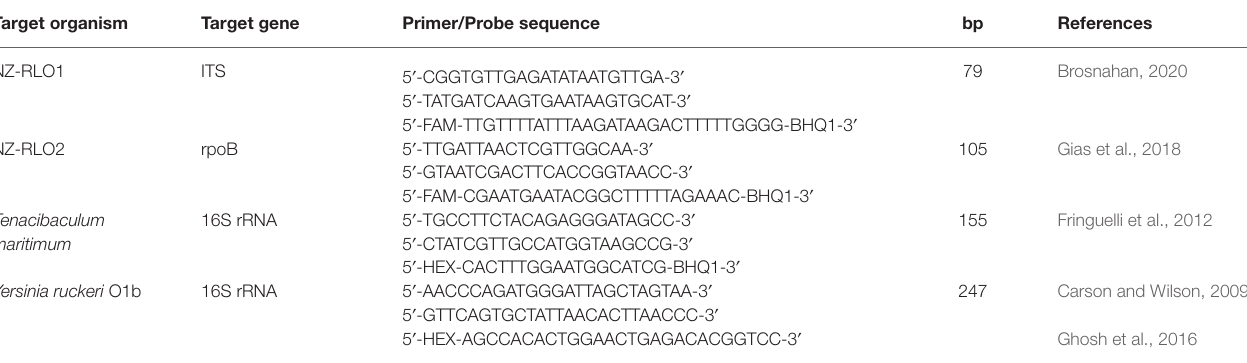
ITS, Internal transcript spacer region; rpoB, the β -subunit of the bacterial RNA polymerase; 16S rRNA, bacterial 16S ribosomal RNA gene. Probes were labeled with either 6-Carboxyfluorescein (FAM) or Phosphoramidite (HEX) fluorescent dye on the 5 ′ -end and a Black Hole Quencher 1 (BHQ®-1) on the 3 ′ -end. Bp, Base pairs of the targeted gene sequence.